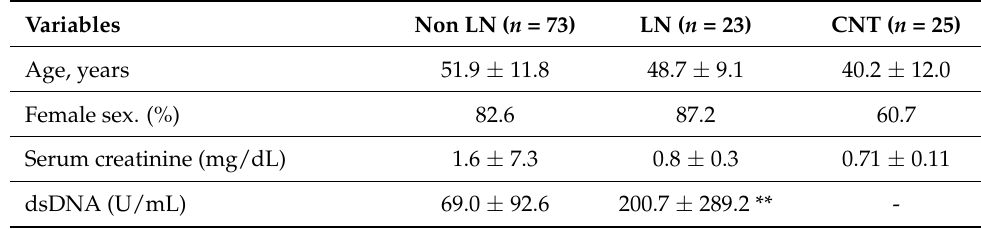
Table 1. Clinical characteristics of study patients’